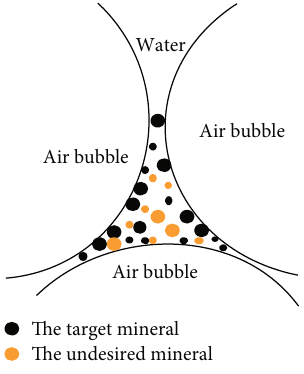
Figure 1: Schematic of froth entrainment in fl otation.